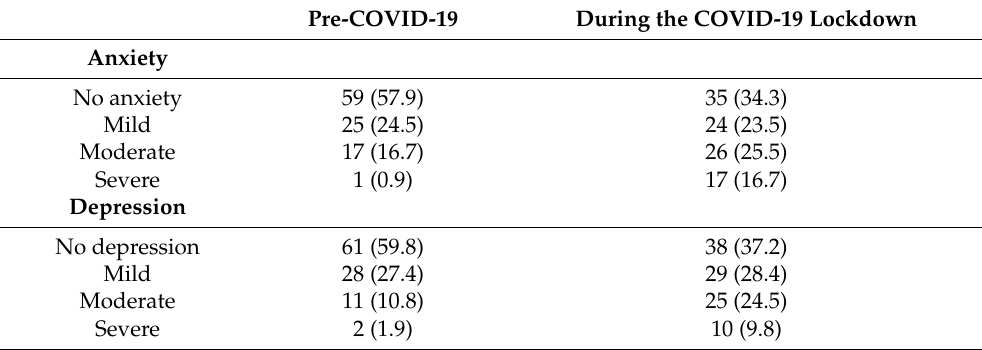
Table 5. Categorisation of anxiety and depression levels according to severity of the re- ported symptoms.